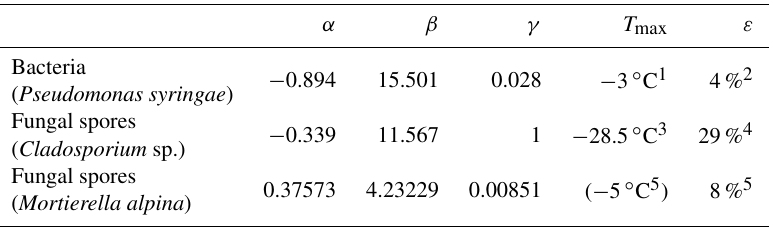
Table 2. Parameters for parameterizing the heterogeneous ice-nucleating ability of different PBAPs used in the model simulation of this study (Eqs. 3, 4, 5, 6).